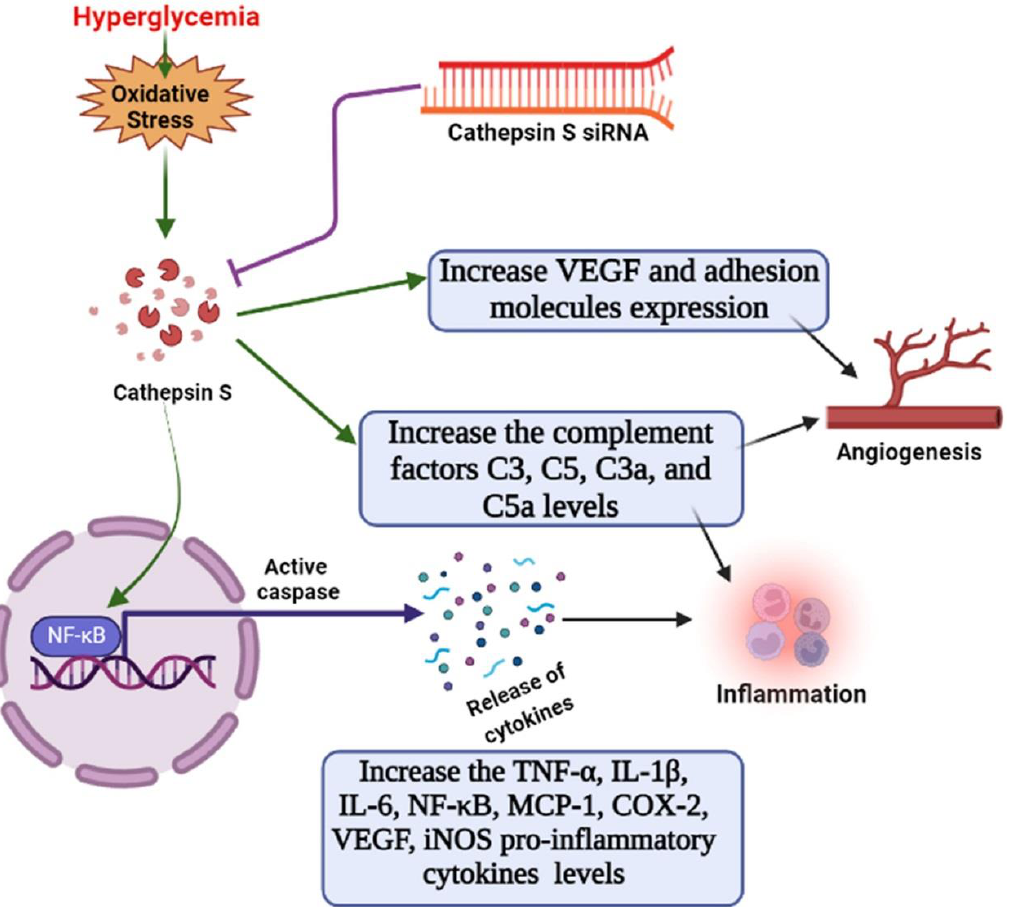
Figure 5. Schematic diagram. The role of cathepsin S in the activation of angiogenesis, complement factors, and endothelial inflammation via the NF- κ B pathway under hyperglycemic conditions in HUVECs, as well as the suppressive effects of cathepsin-siRNA on inflammatory responses.